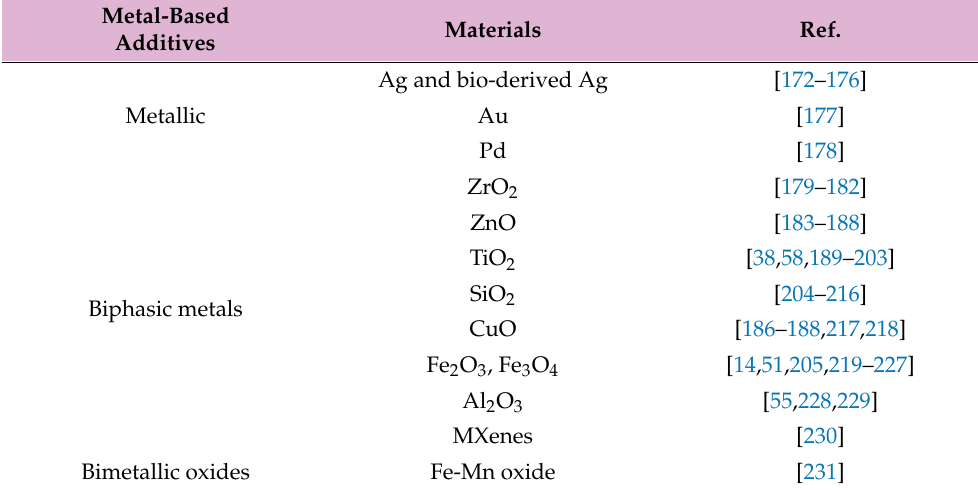
Table 2. Metal-based antifouling additives used in the last 10 years for the blending modification of polymeric